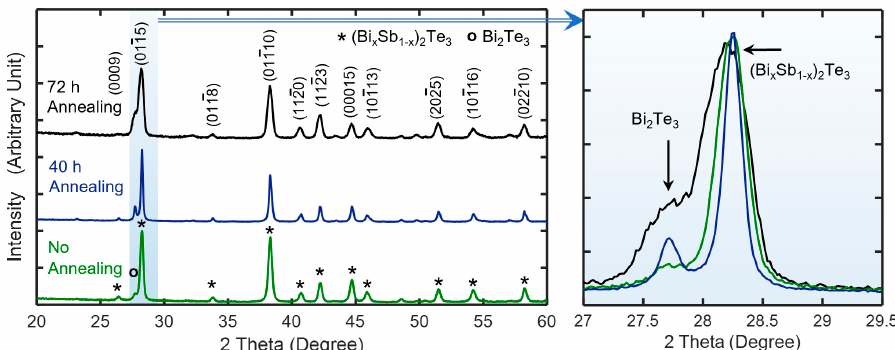
Figure 5. XRD patterns of the annealed (Bi x Sb 1 − x ) 2 Te 3 -5% glass samples at 230 °C after 0, 40, and 72 h. The inset shows the comparison of the main peaks at 2 θ = 27 to 29.5.